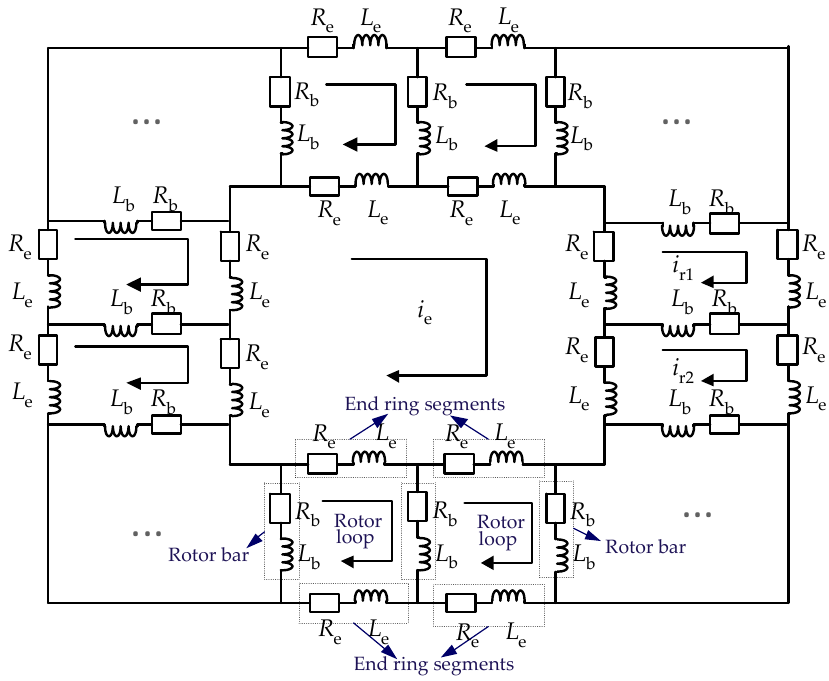
Figure 1. Equivalent circuit of the rotor cage with multiple-coupled-loops.